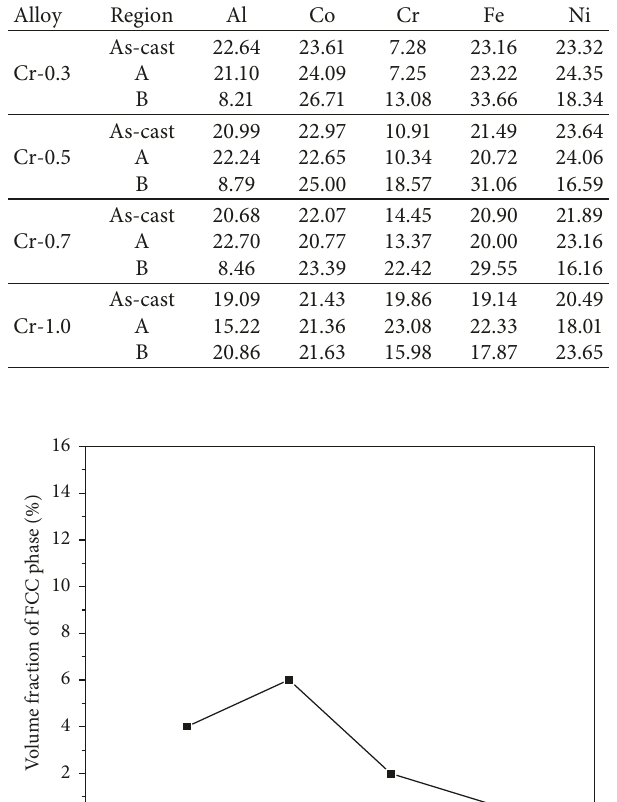
Table 1: EDS results for alloys Cr-0.3 to Cr-1.0 (at.%).